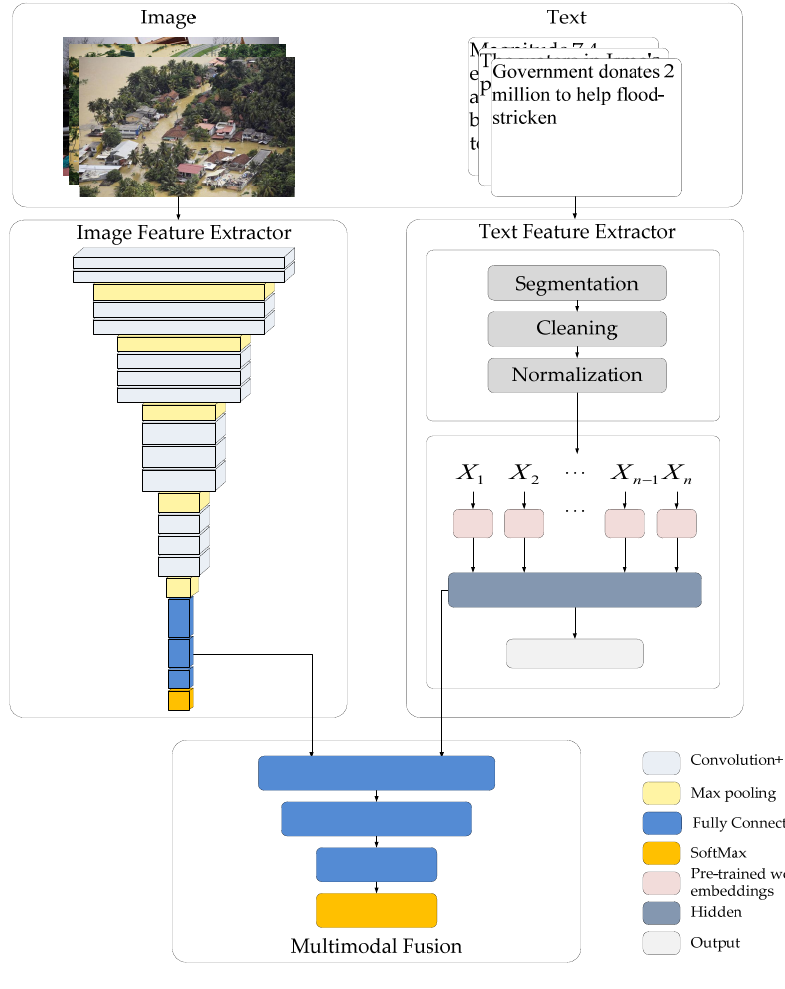
Figure 1. The proposed model framework. Table 6. The hierarchical architecture of adjusted VGG16 (Num_Classes indicates the number of classes, and FC means fully connected